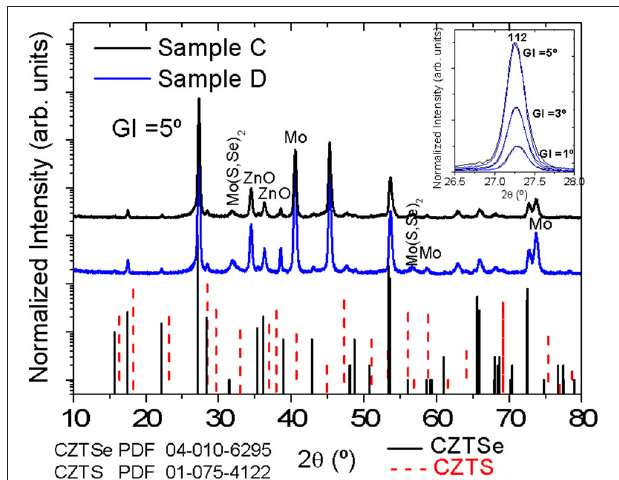
FIGURE 3 | GIXRD patterns of samples C and D exhibiting reflexes of CZTSSe, Mo and Mo(S,Se) 2 . A zoom of the 112 Bragg peak measured at different grazing incidence angles do not show any significant difference between both samples. The PDF files number 04-010-6295 corresponding to CZTSe (solid line) and number 01-075-4122 assigned to CZTS (dash line) are also plotted.